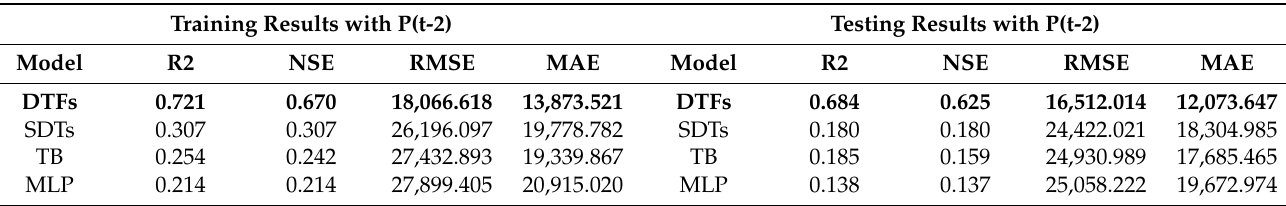
Table 5. Training and testing results with Q(t-2) of different data mining techniques.